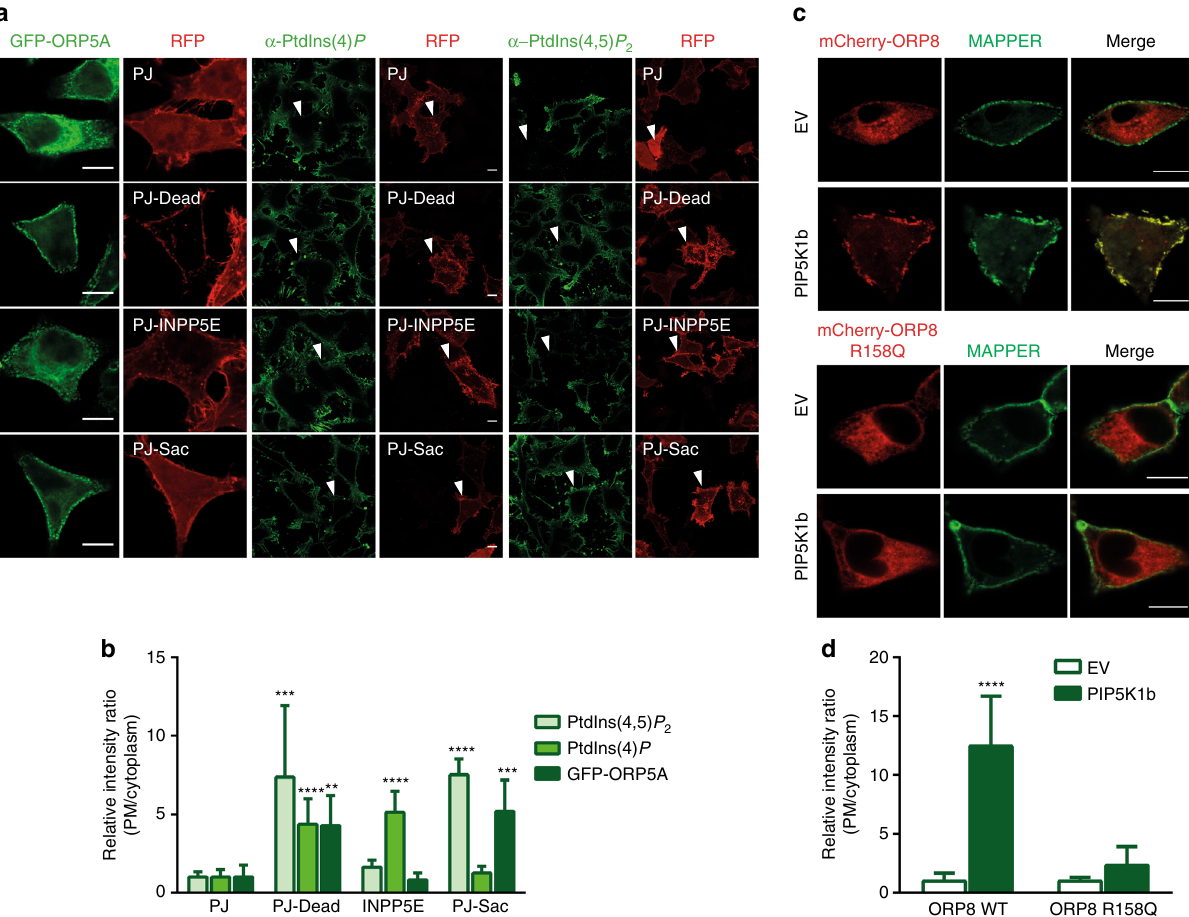
Fig. 3 Distribution of ORP5 to the ER – PM junctions is PtdIns(4,5) P 2 dependent. a Effect of PJ (a fusion protein of inositol polyphosphate-5-phosphatase E (INPP5E) and the S. cerevisiae Sac1 phosphatase), PJ-Sac (with inactivated INPP5E domain), or PJ-INPP5E (lacking the sac domain) on GFP – ORP5A, PtdIns (4) P and PtdIns(4,5) P 2 distribution after PM recruitment for 5 min with 1 μ M rapamycin. b Quantitation of PM/cytoplasm intensity ratio of GFP – ORP5A, PtdIns(4) P and PtdIns(4,5) P 2 in relation to the effect of PJ and its mutants as in a (mean + s.d.; **** P < 0.0001; *** P < 0.001; **P < 0.01, one-way ANOVA, n = 8 – 15 cells). c Co-localization of mCherry – ORP8L and mCherry – ORP8L R158Q with MAPPER upon PIP5K1b overexpression. d Quantitation of PM/ cytoplasm intensity ratio of mCherry – ORP8L and -ORP8L R158Q as shown in c (mean + s.d.; **** P < 0.0001, t test, n = 6 cells). Bar = 10 μ